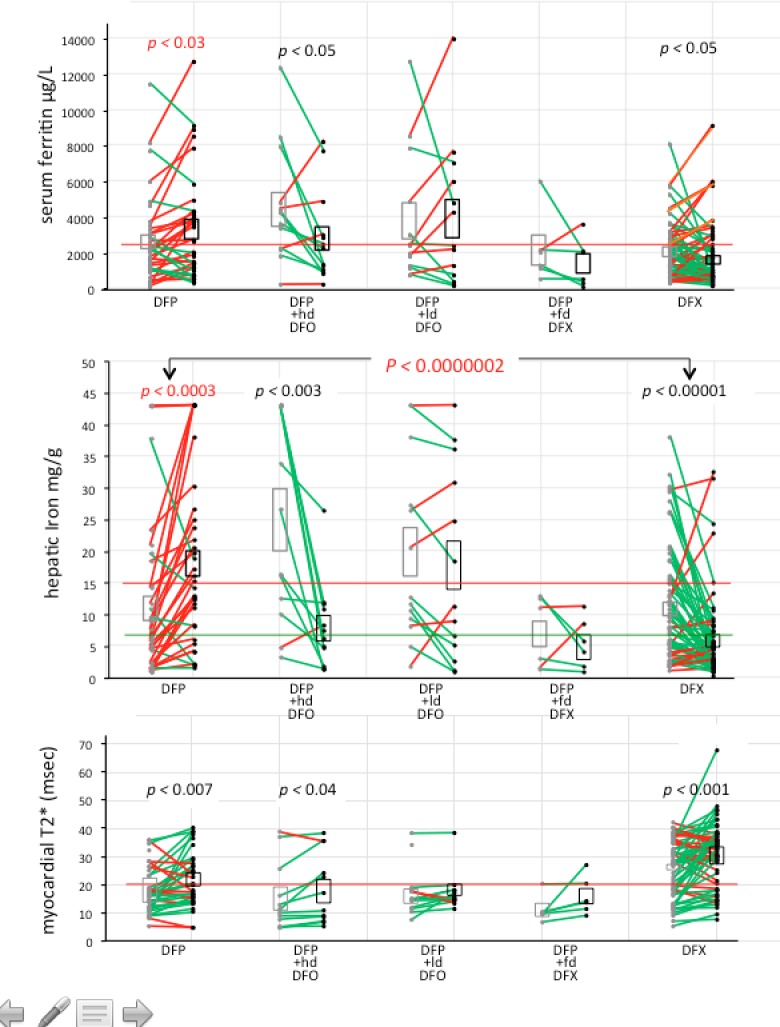
Scatter plots of data points reflecting body iron load.Mean±SEM (range) of values bracketing intervals of deferiprone (DFP) [36] and deferasirox (DFX) [62] monotherapy, and DFP with high dose (hd) [13] and low dose (ld) [13] DFO, and full dose (fd) DFX [6] combination therapies. Grey symbols are baseline (BL) values; black symbols are follow-up (FU) values. BL and FU values for each interval are connected by lines (red lines indicate worsening of iron load over the interval; green lines indicate improvement of iron load over the interval; p values corresponding to worsening body iron are red.